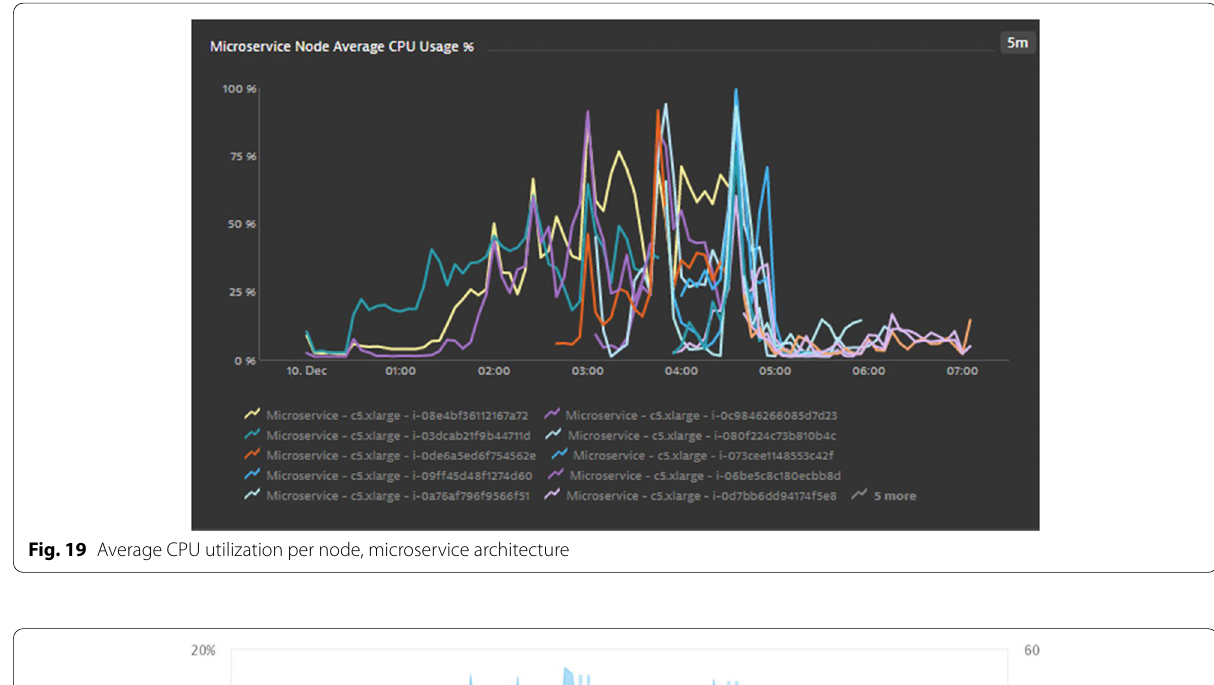
Fig. 19 Average CPU utilization per node, microservice architecture